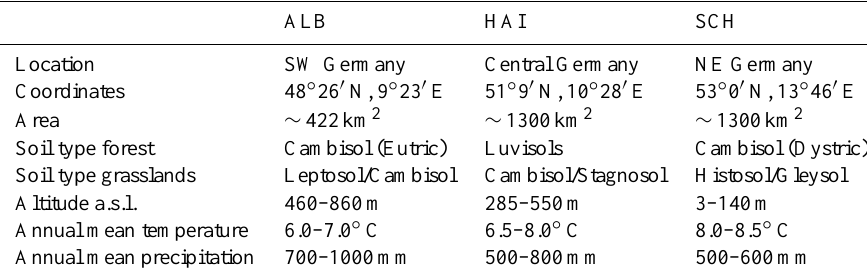
Table 1. Main geographical and environmental characteristics of the three study